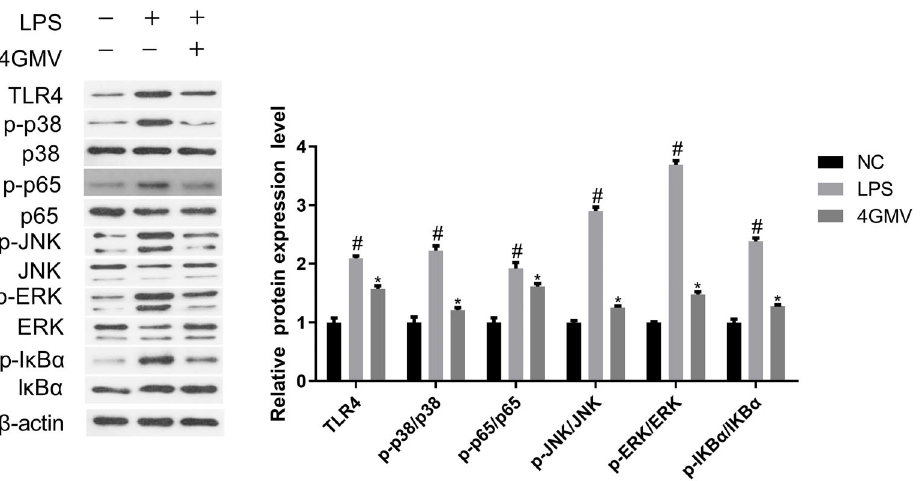
Figure 8. Effect of 4 ’ -O- b -D-glucosyl-5-O-methylvisamminol (4GMV) on NF- k B and MAPK signaling pathways in lipopolysaccharide (LPS)-stimulated RAW 264.7 cells. RAW 264.7 cells were pretreated with 100 m M 4GMV and exposed to 1 m g/mL LPS for 1 h. Protein expressions of toll-like receptor 4 (TLR4), phosphorylated p38, c-Jun N-terminal kinase (JNK), extracellular signal-regulated kinase (ERK), nuclear factor of kappa light polypeptide gene enhancer in B-cells inhibitor, alpha (I k B a ), and p65 were analyzed by western blot. Data are reported as means ± SD (n=3) of three independent experiments. # P o 0.05 vs control; *P o 0.05 vs the LPS-treated group (ANOVA followed by LSD). NC: negative control ( b -actin). NF- k B: nuclear factor kappa-light-chain-enhancer of activated B cell; MAPK: mitogen-activated protein